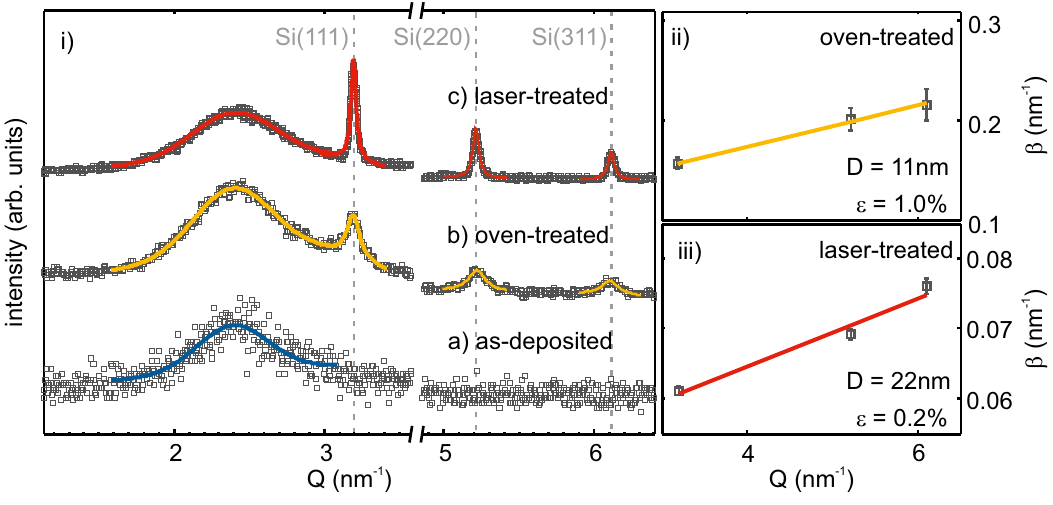
Figure 3. ( i ) XRD patterns of SiO 0.6 layers on SiO 2 : as-deposited (a), after conventional oven (b) and after laser treatment (c). The broad peak at about 2.4nm − 1 originated from the a-SiO 2 matrix and silica substrate. Measurement data are shown by grey squares. The solid lines represent fitted curves. ( ii , iii ) The determined diffraction peak width is plotted vs. its position; the linear regression was made for Williamson–Hall analysis to retrieve crystallite size D and micro-strain (cid:101) for the oven- ( ii ) and laser-treated ( iii )